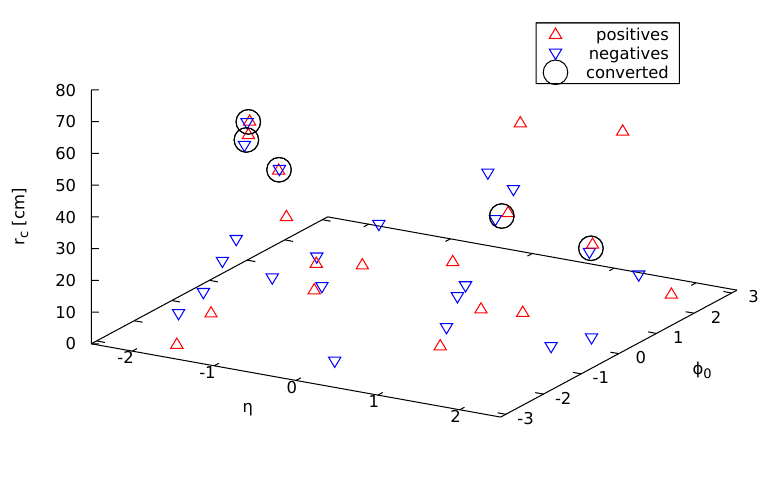
Figure 4. Identification of photon conversions in the ( η , φ 0 , rc ) space of track candidates.